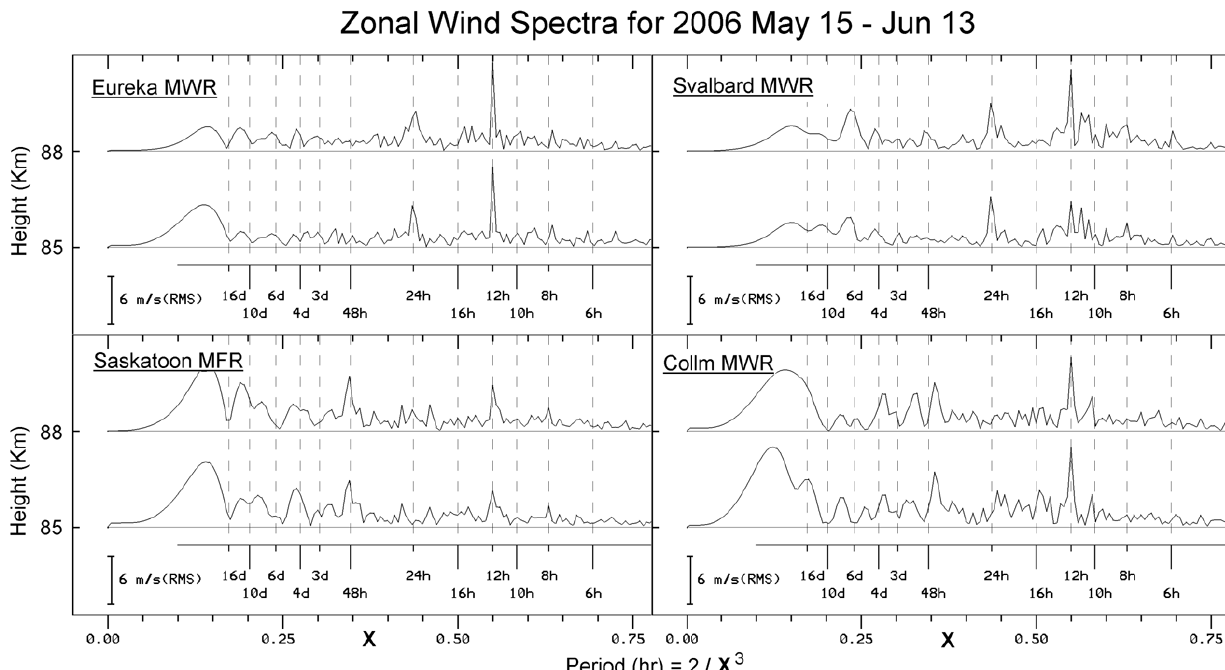
3 Fig. 3. Frequency spectra for two Arctic and two high mid-latitude radar-locations during early summer months. Otherwise the figure is g . F i